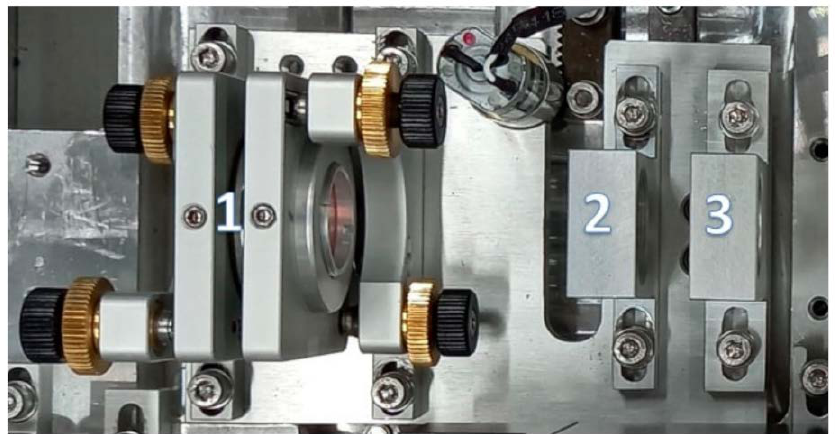
Figure 8. A part of HELIOS-4 laser head with assembled components for Ti:Sapphire laser: 1—mounts with Ti:Sapphire crystal and laser cavity mirrors, 2—holder with condenser lens and 3—holder with MLA.